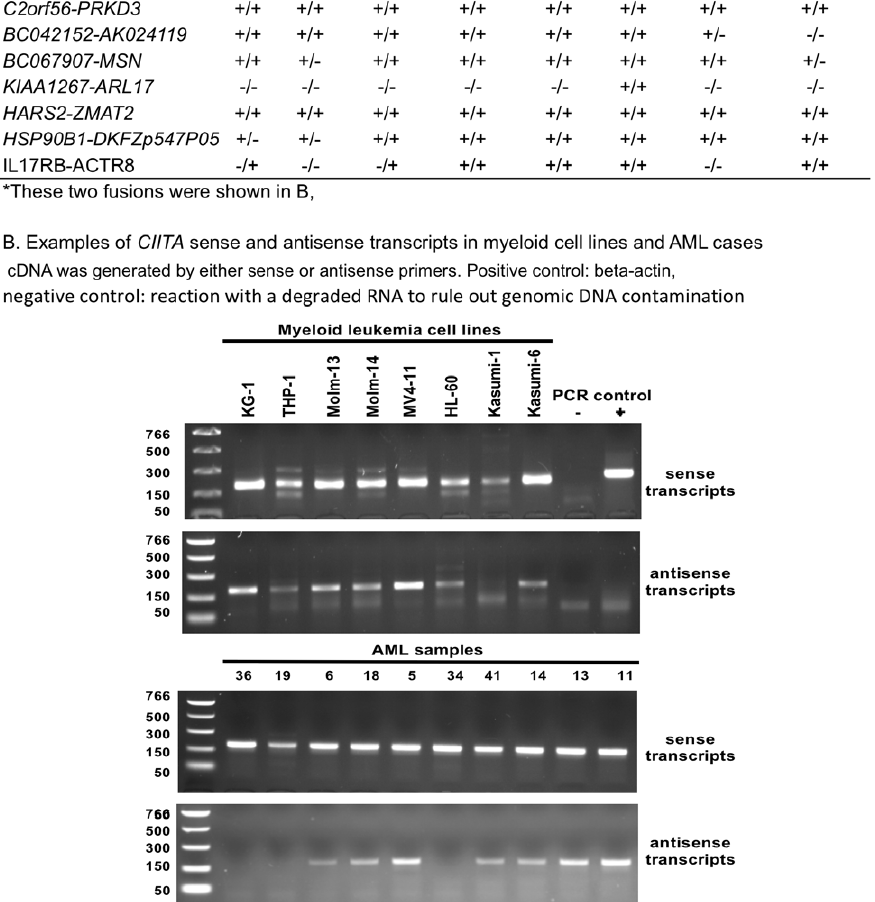
Figure 4. Validation of sense and antisense fusion transcripts by strand-specific RT-PCR. A. Summary for RNA samples from 8 myeloid cell lines. B. CIITA-DEXI sense and antisense fusion transcripts detected in myeloid cell lines and AML samples. + : positive control with beta-actin; -: netative control without RNA templates.